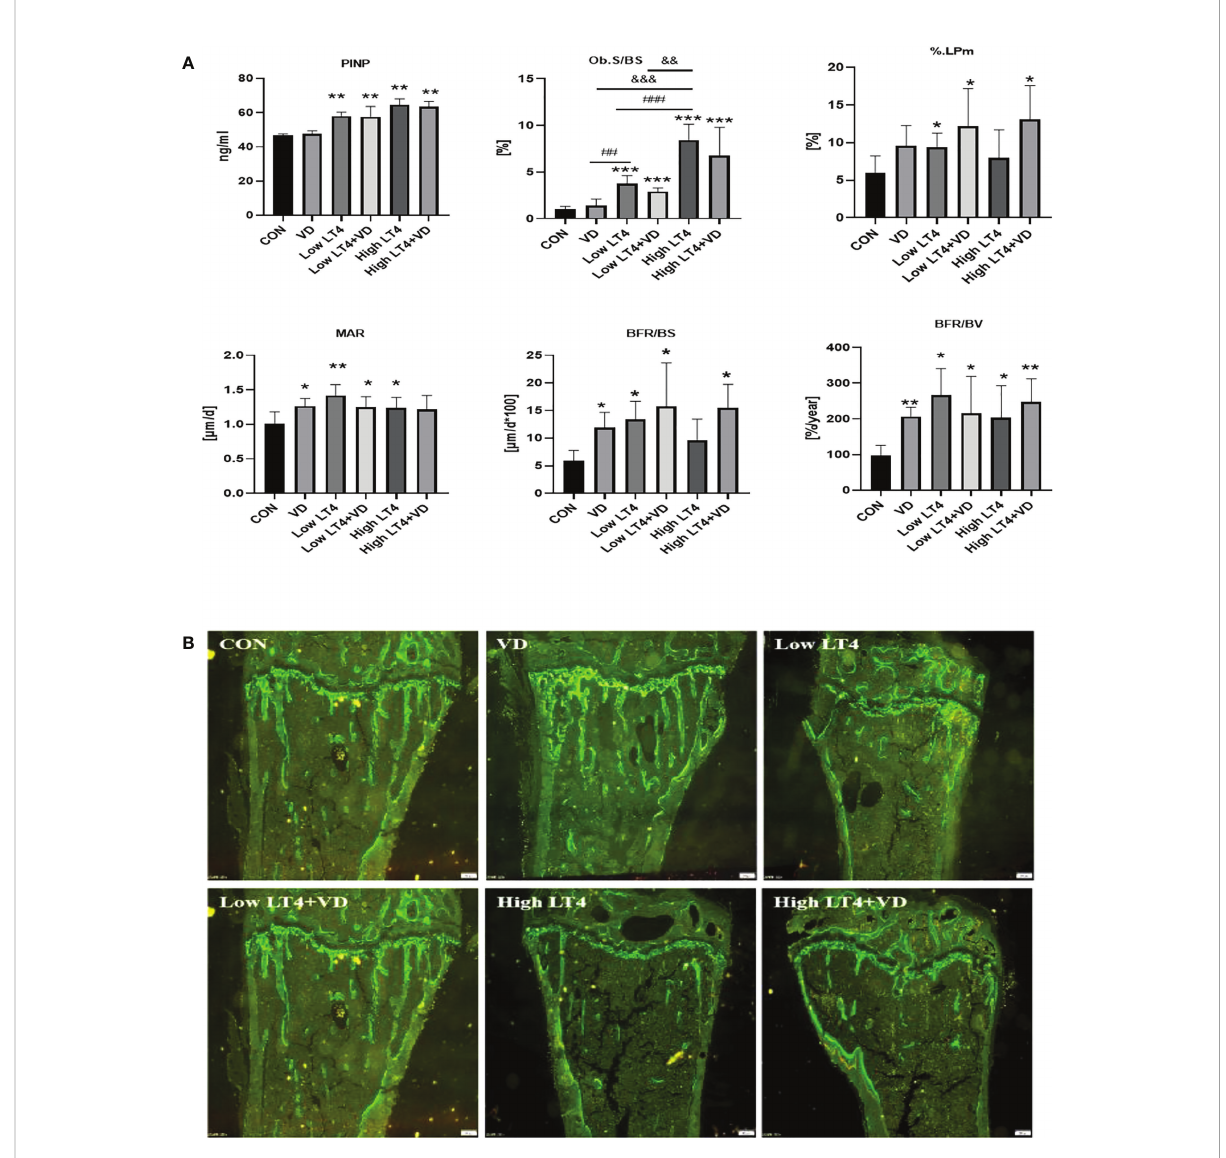
FIGURE 3 Thytoxicosis-induced bone formation is not obviously changed by vitamin D treatment. (A) Bone formation parameters were determined in the CON, VD, Low LT4, Low LT4+VD, High LT4 and High LT4+VD groups. P1NP, procollagen type 1 N-terminal propeptide; Ob. S/BS, osteoblast surface per bone surface; %L. Pm, % label perimeter. MAR, mineral apposition rate of cancellous. BFR/BS, bone formation rate/bone surface. BFR/BV, bone formation rate/bone volume. (B) Representative calcein double labelling of the upper tibia in mice. (A) Data are shown as the means ± SEMs (n=6). Compared with the control group, * P <0.05, ** P <0.01, ***P<0.001. Compared with the Low LT4 group, # P < 0.05, ## P < 0.01,001, ### P < 0.001. compared with the High LT4 group, & P < 0.05, && P < 0.01, &&& P <